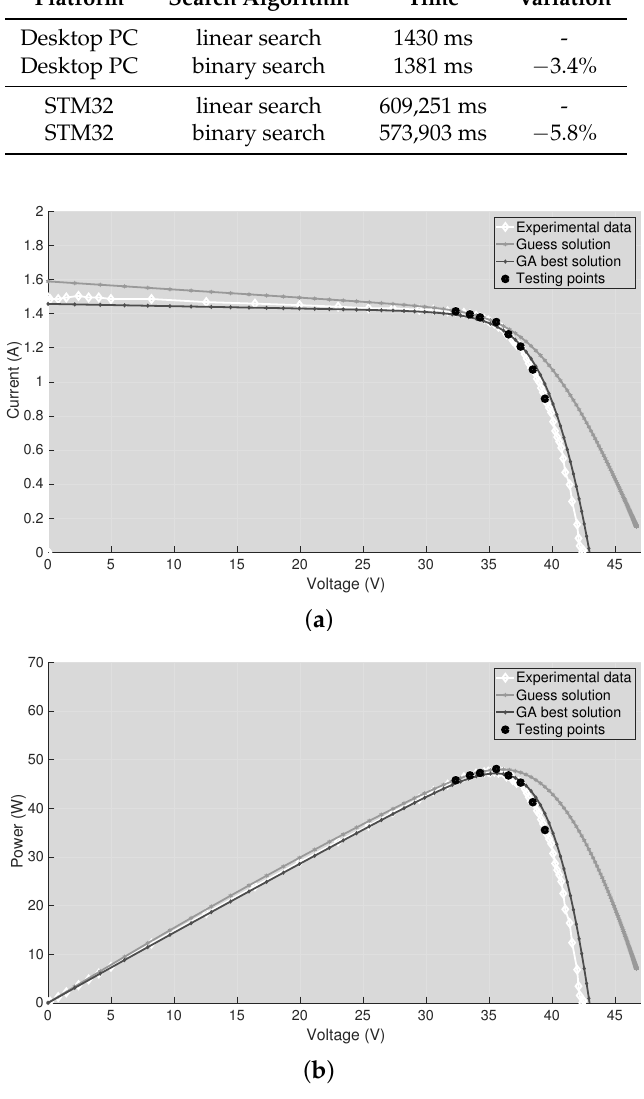
Figure 10. Comparison of the I-V and P-V photovoltaic curves for Test #3. ( a ) Photovoltaic I-V curves; ( b ) photovoltaic P-V